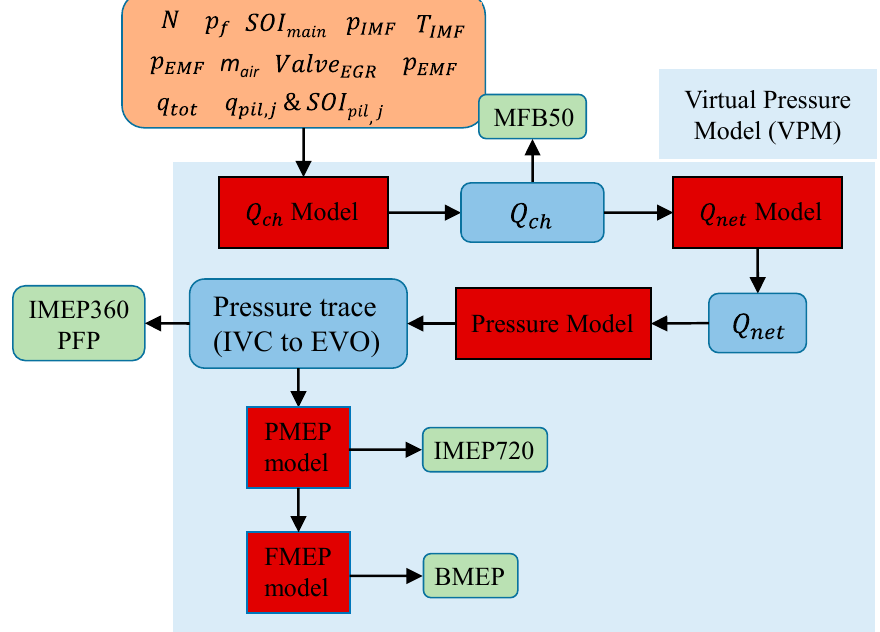
Figure 3. Scheme of the physics-based combustion model [12].